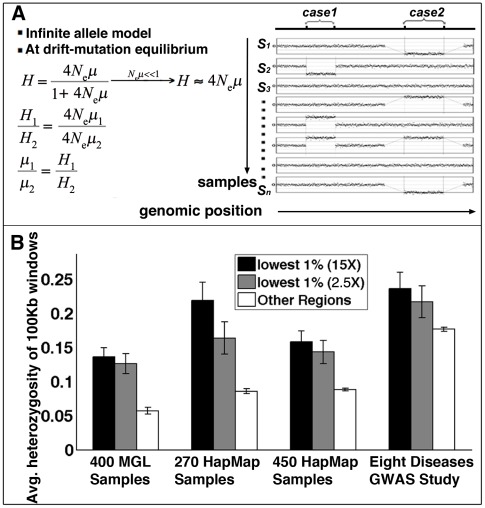
Structural mutability assessed by structural heterozygosity.(A) Under the infinite allele model, assuming structural mutations are neutral and at drift-mutation equilibrium, mutation rates are proportional to heterozygosity rates. (B) Comparison of average CNV heterozygosity rates (data from four studies) within (black for methylomes at 15× coverage, gray for methylomes at 2.5× coverage) and outside (white) methylation deserts. Error bars represent standard deviation of CNV heterozygosity rates in corresponding regions.